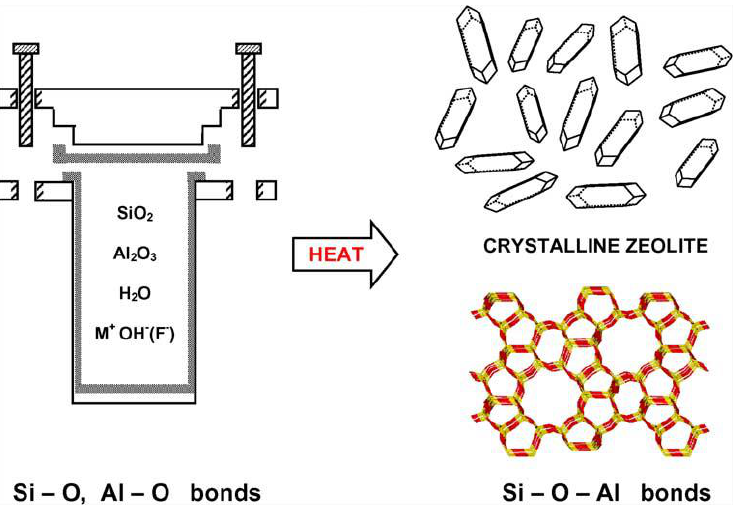
Figure 1. Zeolite synthesis principle. (Reprinted with permission from [6], Copyright: 2005, Else- vier).